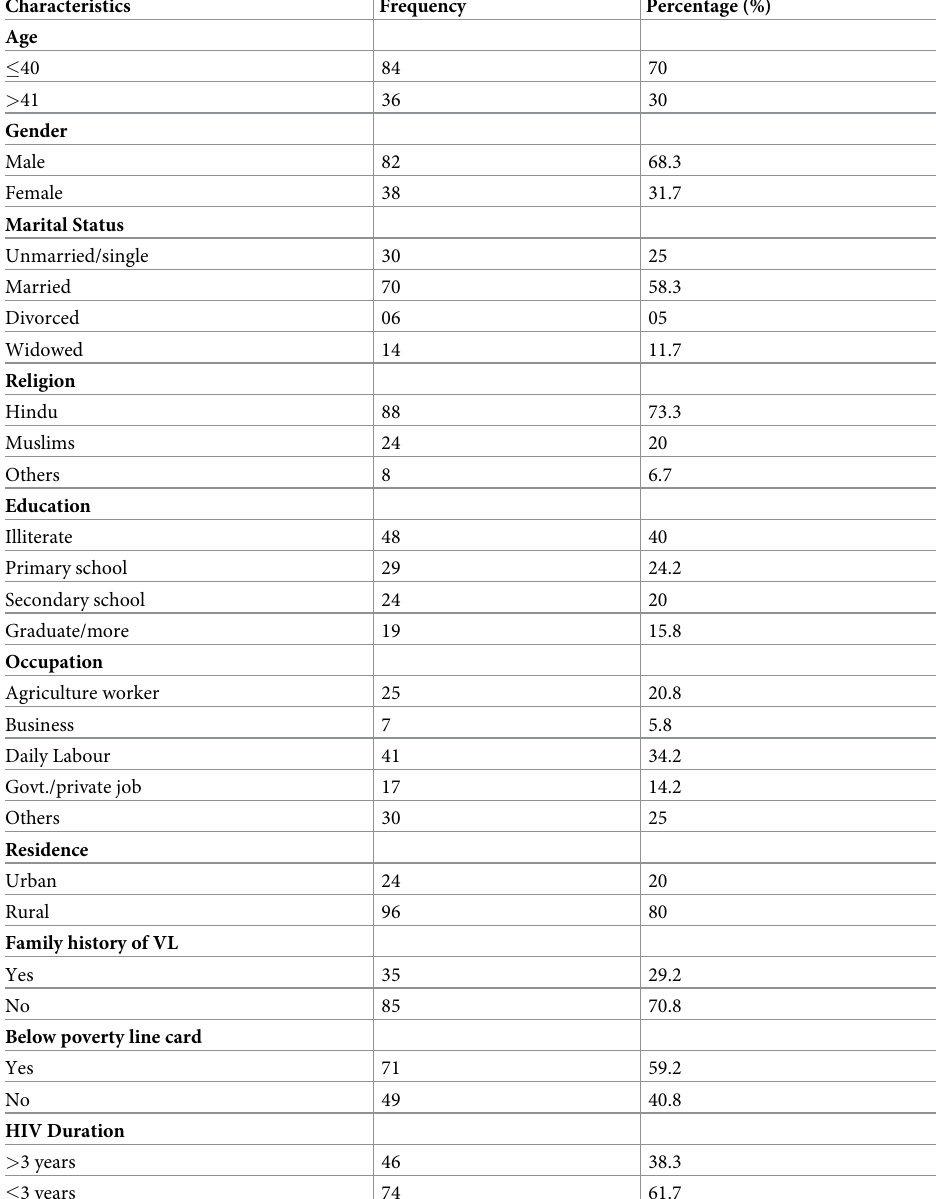
Table 1. Socio- demographic variables of participants (N =